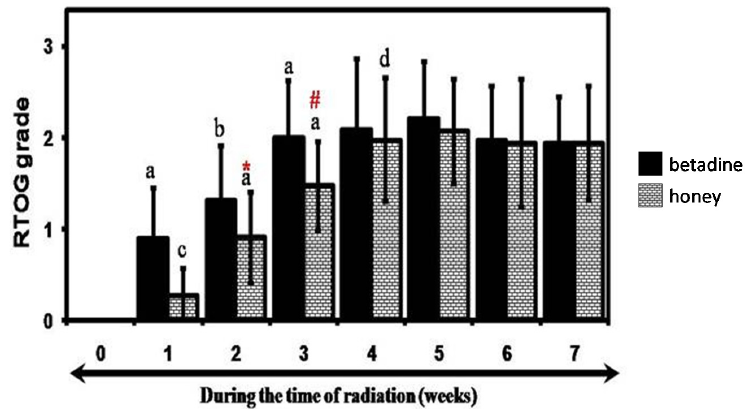
Figure 2. Severity of radiation ‐ induced mucositis in the betadine (solid) and honey (bricked)